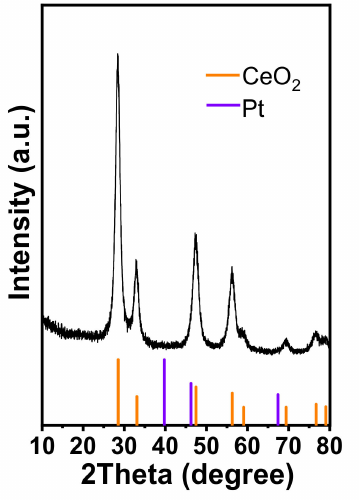
Figure 11. XRD pattern of Pt/CeO 2